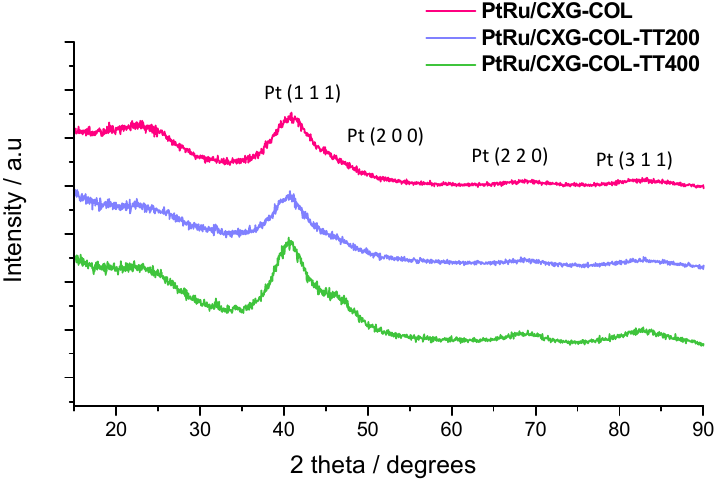
Figure 1. Diffractograms obtained by XRD for the synthesized PtRu catalysts.